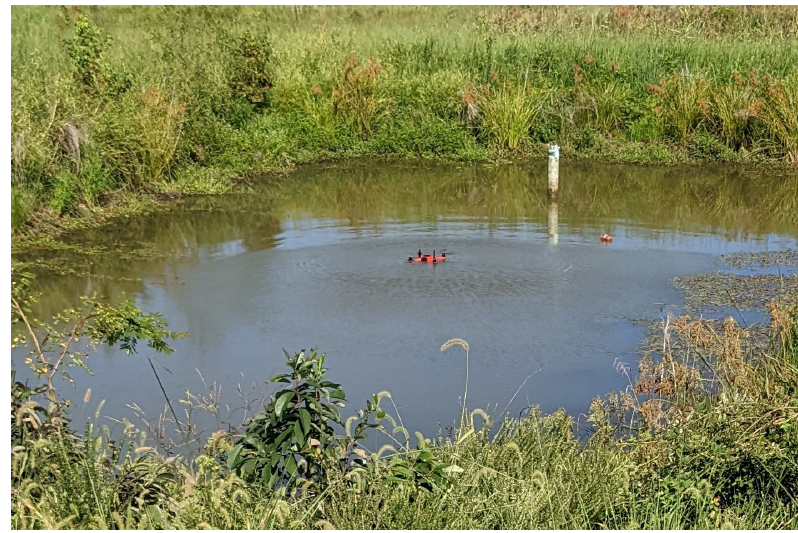
Figure 10. SplashDrone landing in a